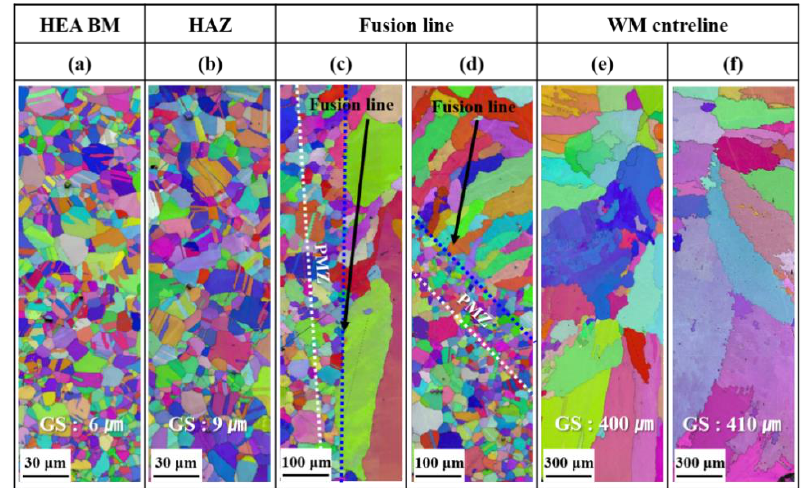
Figure 5. Microstructural behaviour of ( a ) rolled HEA BM, ( b ) HAZ, ( c – f ) near the fusion line and WM centreline using various fillers: ( c , e ) STS 308L and ( d , f ) HEA.